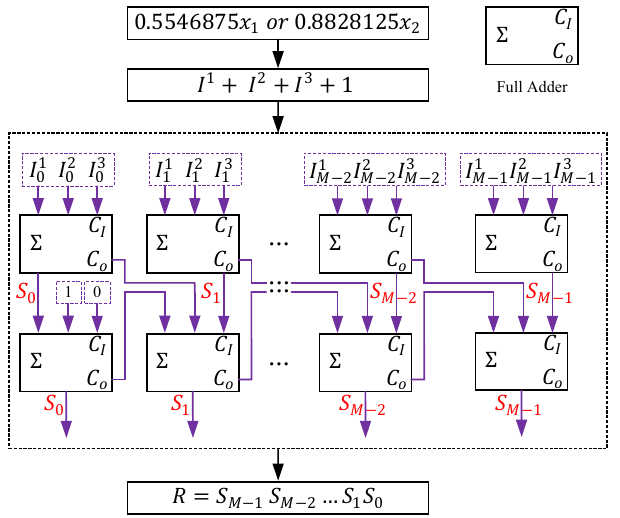
Figure 11. The optimized constant multiplier proposed by carry-save